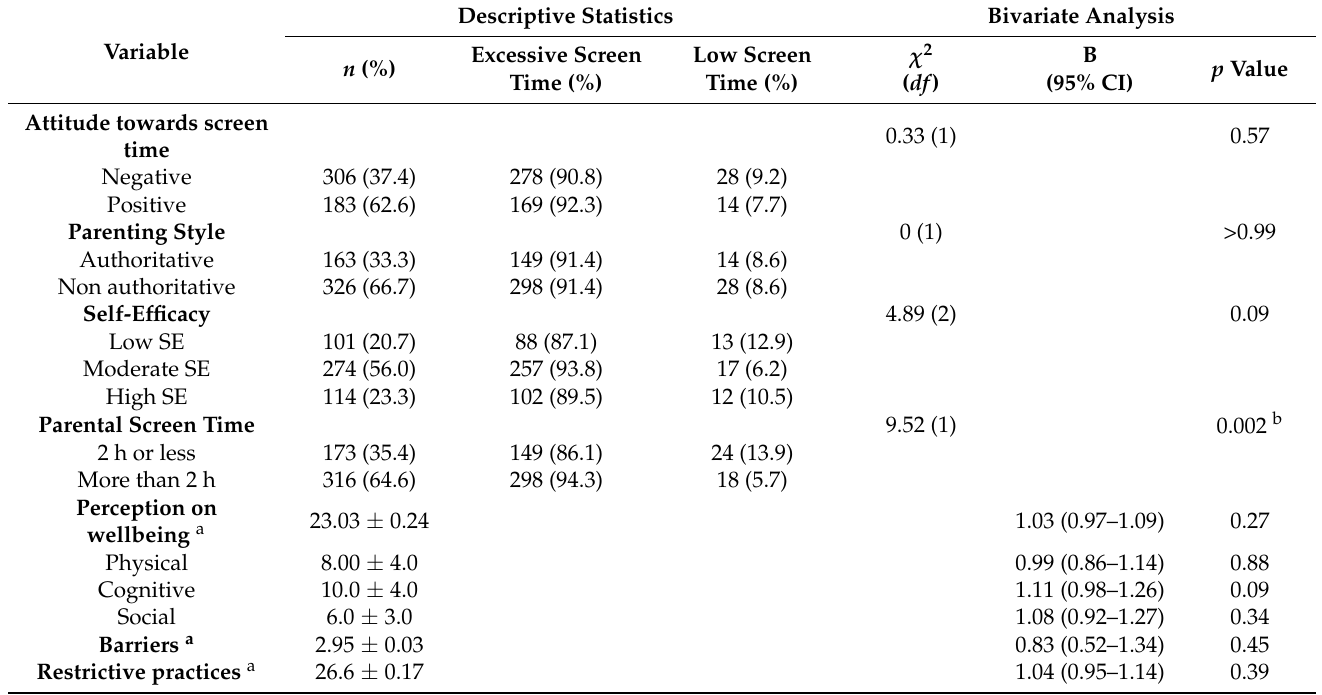
Table 2. Association between parental factors and children screen time.